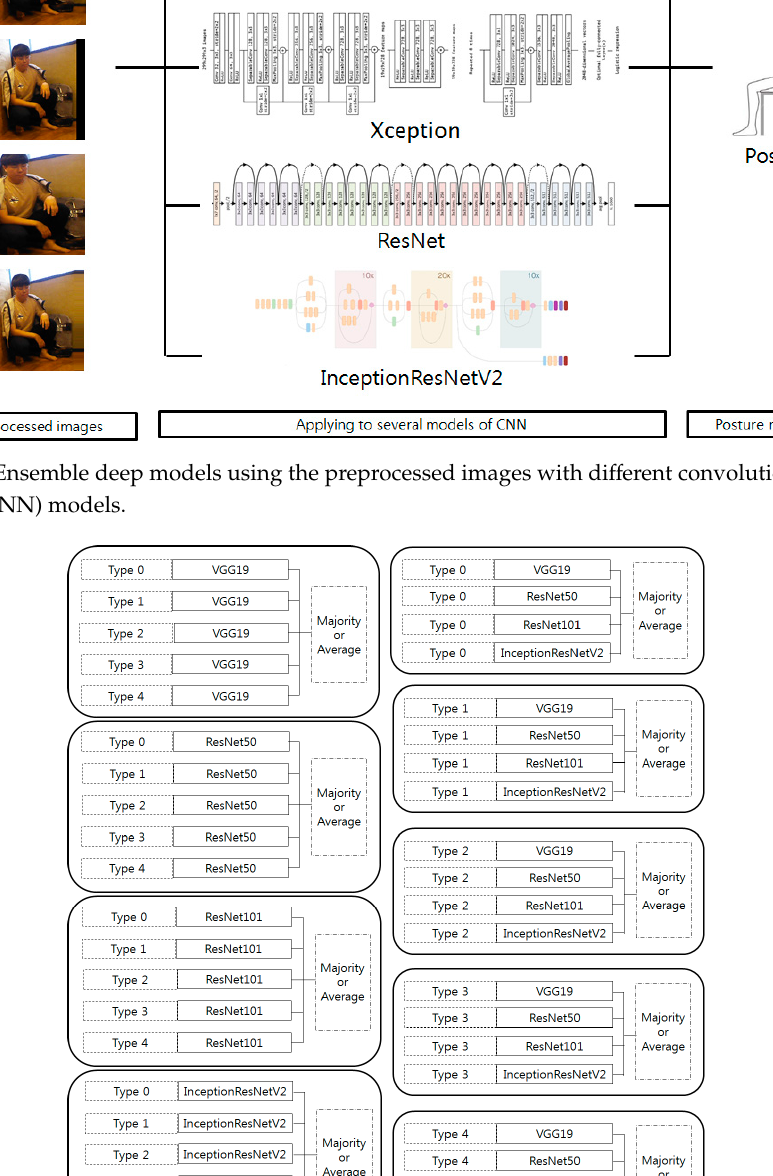
Figure 13. Various ensemble deep models by input types and the pre-trained CNNs.